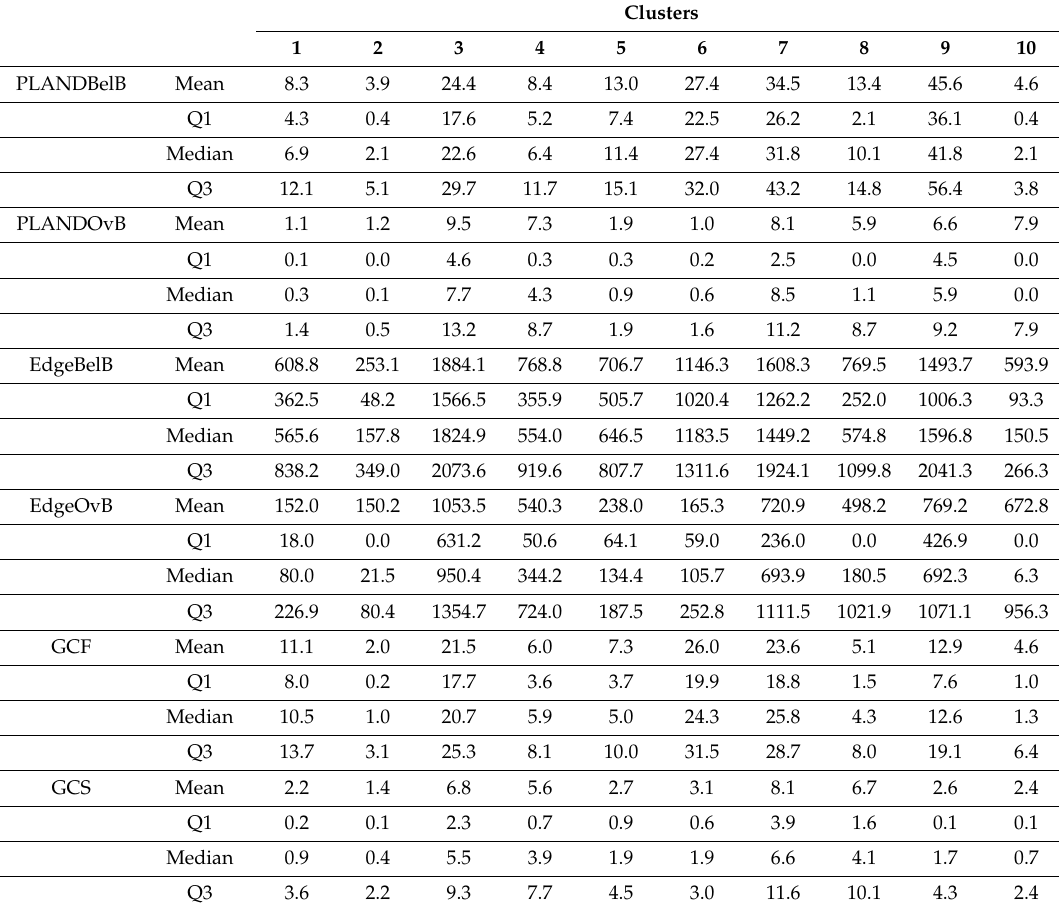
Table 4. Mean, median, first, and tirth quartiles of metrics of the blocks within each cluster. PLANDBelB and PLANDOvB are percent of green detected by remote sensing respectively, below and over the height of block. EdgeBelB and EdgeOvB are the edge density of green detected by remote sensing respectively, below and over the height of block. GCF and GCS are the percent of green detected by segmentation of GSV images respectively, on facades and on sky